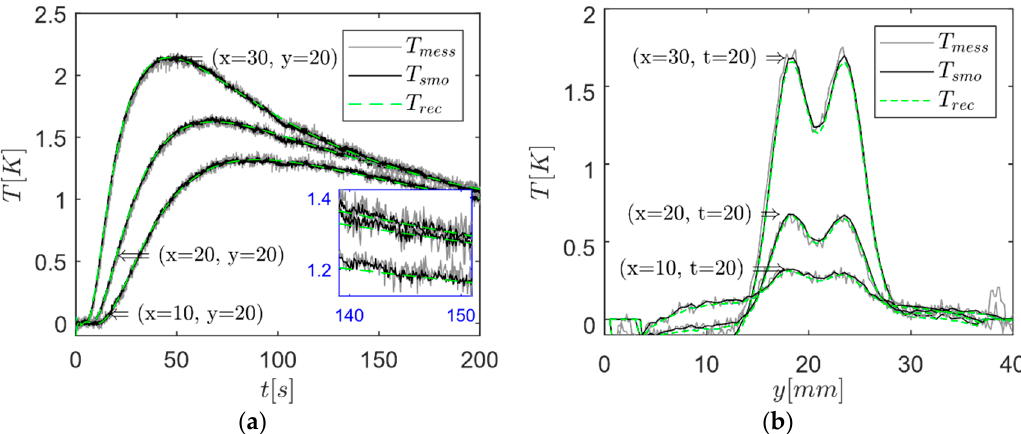
Figure 6. ( a ) Temporal temperature distributions at different positions x and y based on experimental data ; ( b ) temperature field normal to the rods for t = 20 s at different x positions based on experimental data .